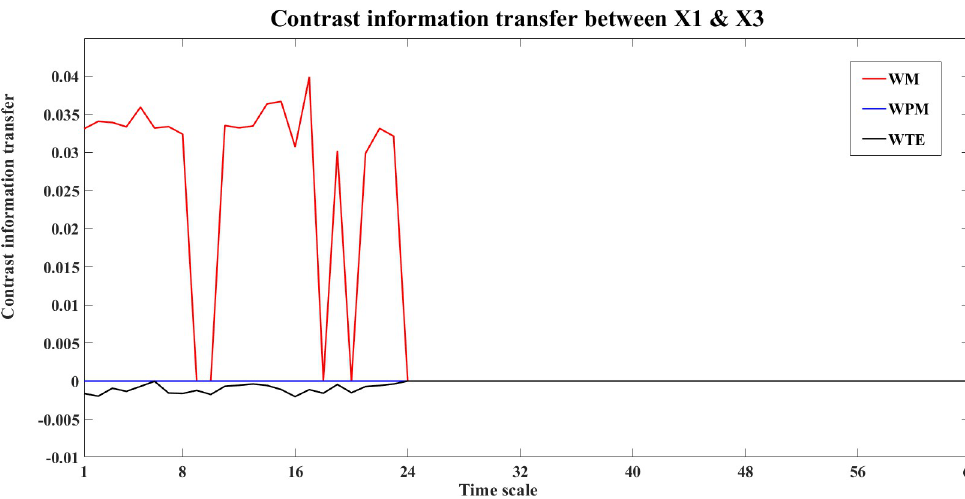
Fig 11. The contrast information transfer values for X1- > X3 for the four unidirectionally coupled Henon maps. This figure shows the contrast WM (red), WPM (blue) and WTE (black) information transfer between X1 and X3 at different time scales s (i = 1,2, ... 64). WM (red) indicate the indirect information transfer from X1- > X3 (positive curves), while i WPM (blue) presents strictly vanished O ( s ) for all scales, which indicates no direct information transfer WPM ,X1 ! X3 i between X1 and X3. WTE (black) presents subtle but negative O WTE ,X1 ! X3 ( s i ) which indicates false information transfer from X3- >